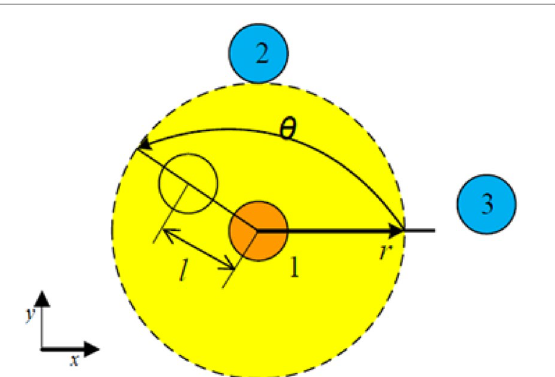
Figure 3 Local perturbation of fiber coordinates